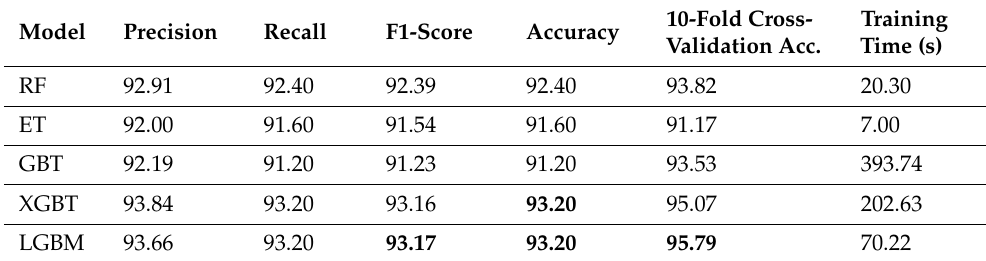
Table 9. Results on the test set with 100 packets as input.